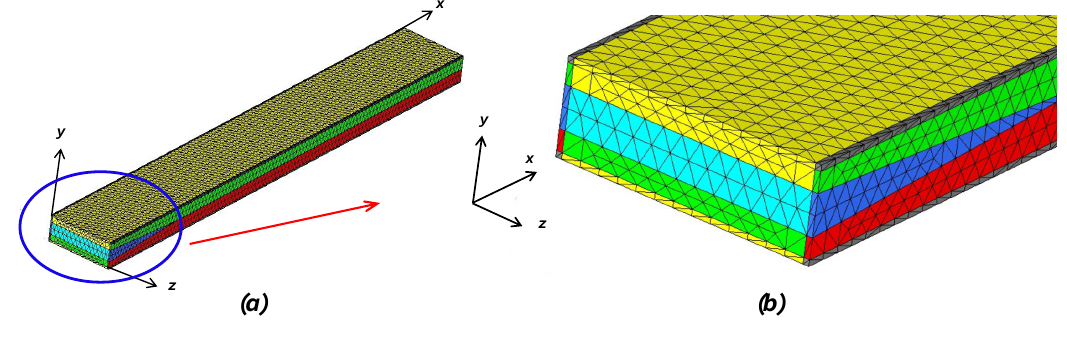
Figure 3. ( a ) Typical finite element mesh with liner tetrahedral elements in Hypermesh [37]; ( b ) zoomed part of the root showing the nodal continuity of different parts of composite laminate in the finite element (FE)